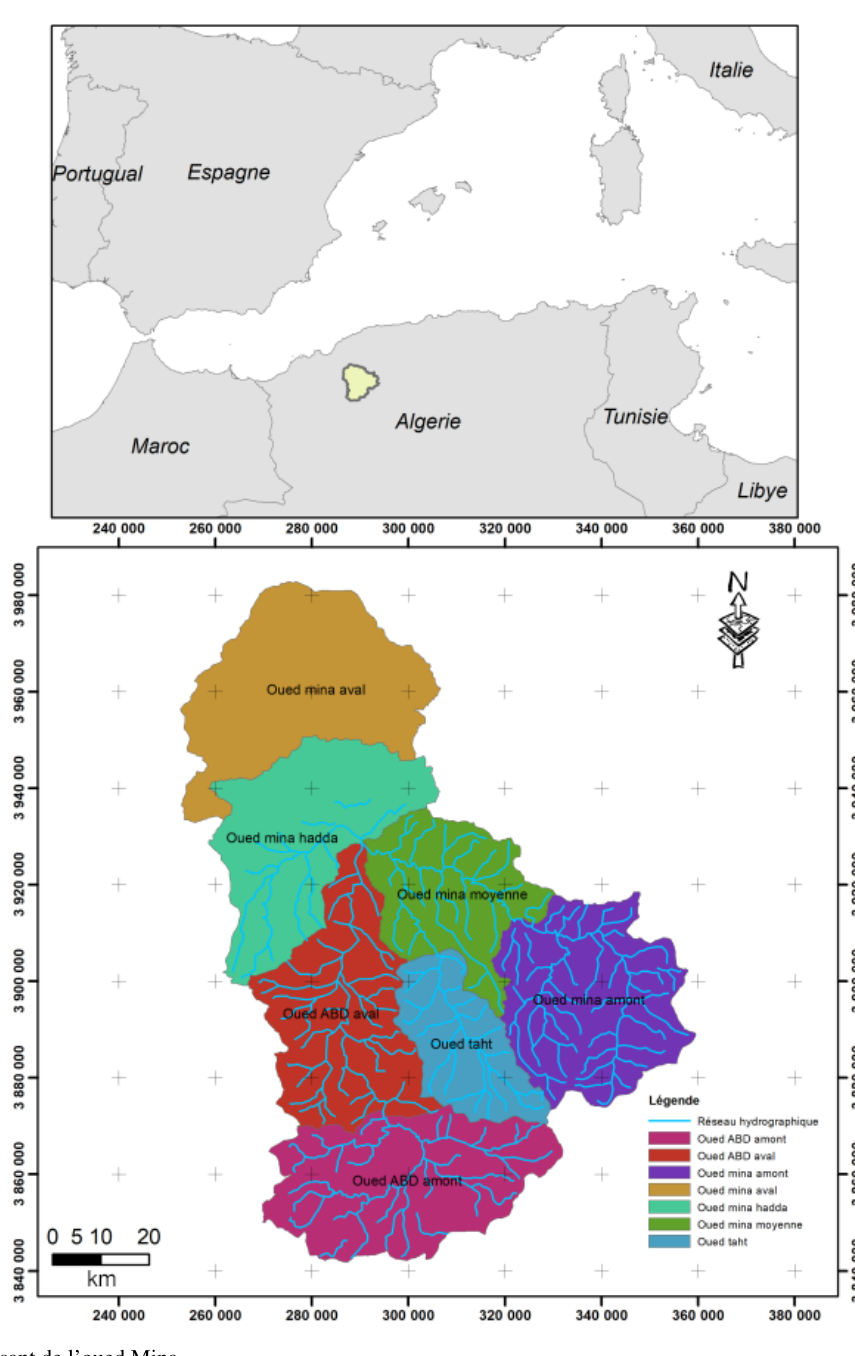
Figure 1. Bassin versant de l’oued